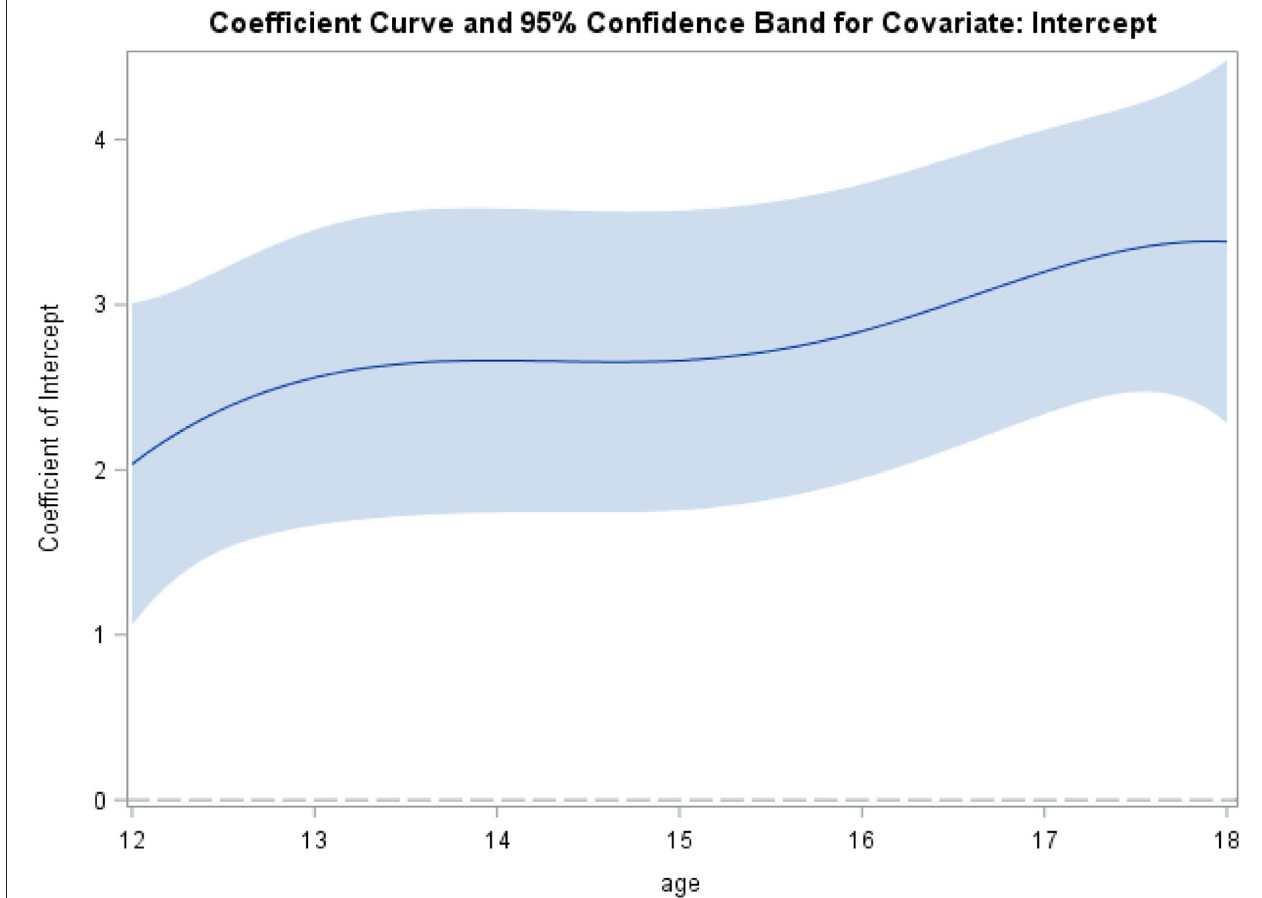
FIGURE 2 | Age-varying associations between borderline personality features and identity disturbance.